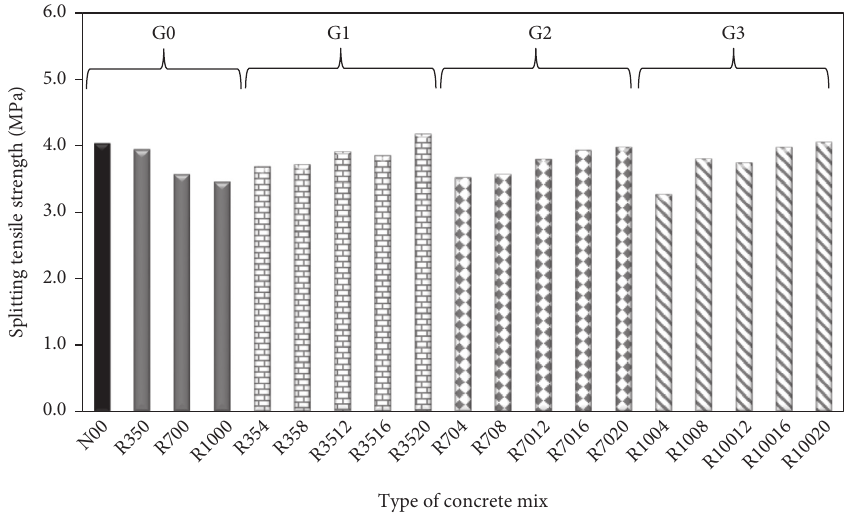
Figure 13: Splitting tensile strength at the age of 28 Table 6: Results of flexural strength of all mixes (strength values and normalized strength). Group